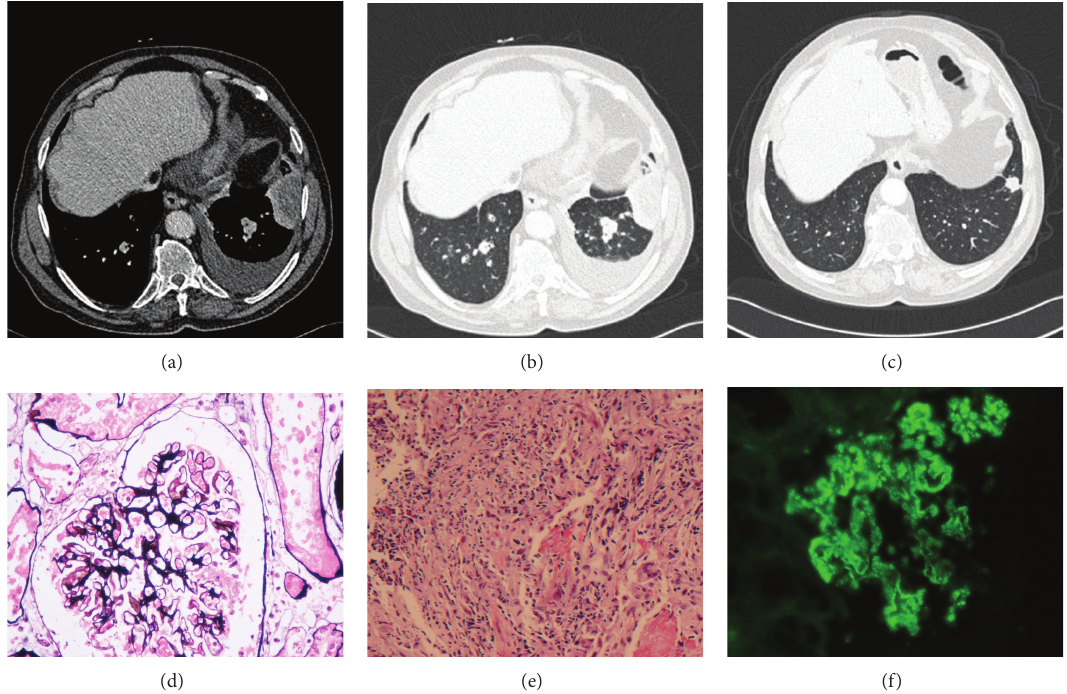
Figure2: (a)Initialcontrast enhanced CTreveals a mass-likelesionwith hypoattenuated area intheleft costophrenicangle. Pleural effusionis also noted in the left side. (b) Initial CT. Lung window scan reveals the mass-like lesion in the left costophrenic angle. Nodular lesions are also visible bilaterally. (c) Follow-up CT. Lung window settings, at the same level eight months later, show a nodule in the left costophrenic angle. The parenchymal nodules have disappeared. (d) Mild, diffuse, nonhomogeneous thickening of capillary basal membrane with rare micro- vacuolar degeneration of the basal membrane (Silver, × 400). (e) CT-guided lung biopsy shows a core of alveolar parenchyma in which there is intra-alveolar organisation associated with a non-specific chronic inflammatory cell infiltrate. In addition, there are areas of basophilic necrosis containing neutrophilic and fibrinoid debris. Occasional histiocytic giant cells are noted within the inflammatory cell infiltrate, although no definitive coalescent granuloma is seen. EVG staining shows that this neutrophilic/necrotic infiltrate is focally centred on the walls of the pulmonary vasculature with some loss and fragmentation of the elastin layers. (f) Non-homogeneous of IgG immunoglobulin along the capillary basal membrane walls exhibiting granular or pseudolinear distribution (IF, ×